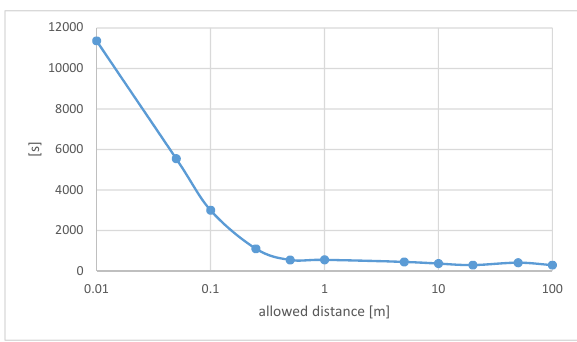
Figure 7. Runtime for different allowed distances .